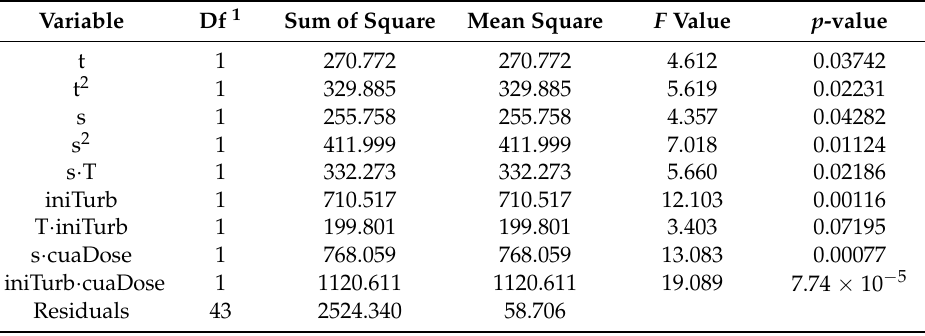
Table 9. ANOVA values for the “finTurb” quadratic model for ECOTAN BIO G150.